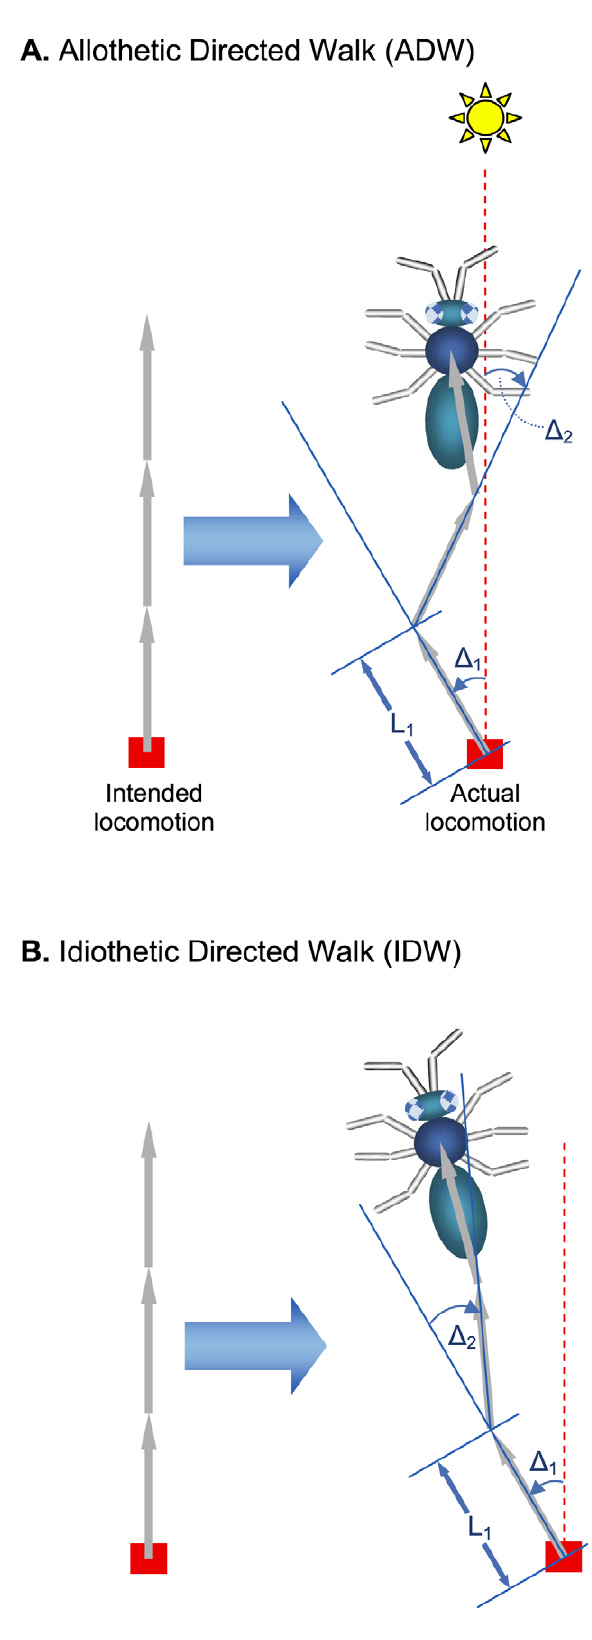
Figure 1. Illustration of simple directed walks. ( A ) An allothetic directed walk (ADW) occurs when the navigating agent measures current heading directly from an external reference (a